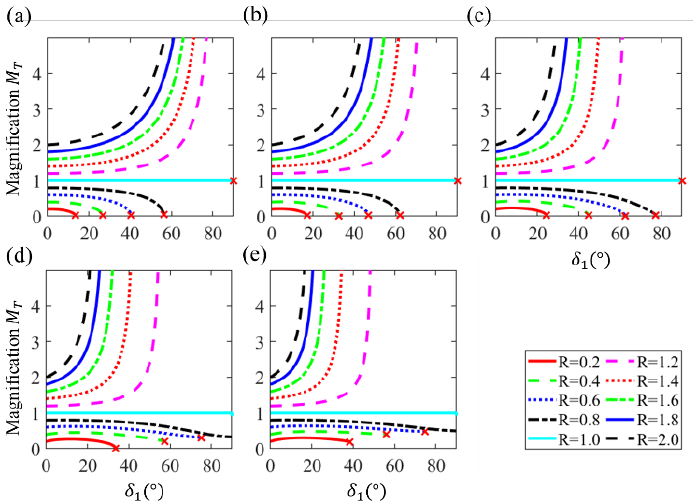
Figure 10. Effect of h 1 on torque magnification in a single four-bar linkage finger structure: ( a ) h 1 = 0.2 L , ( b ) h 1 = 0.5 L , ( c ) h 1 = 1.0 L , ( d ) h 1 = 1.5 L , and ( e ) h 1 = 2.0 L .